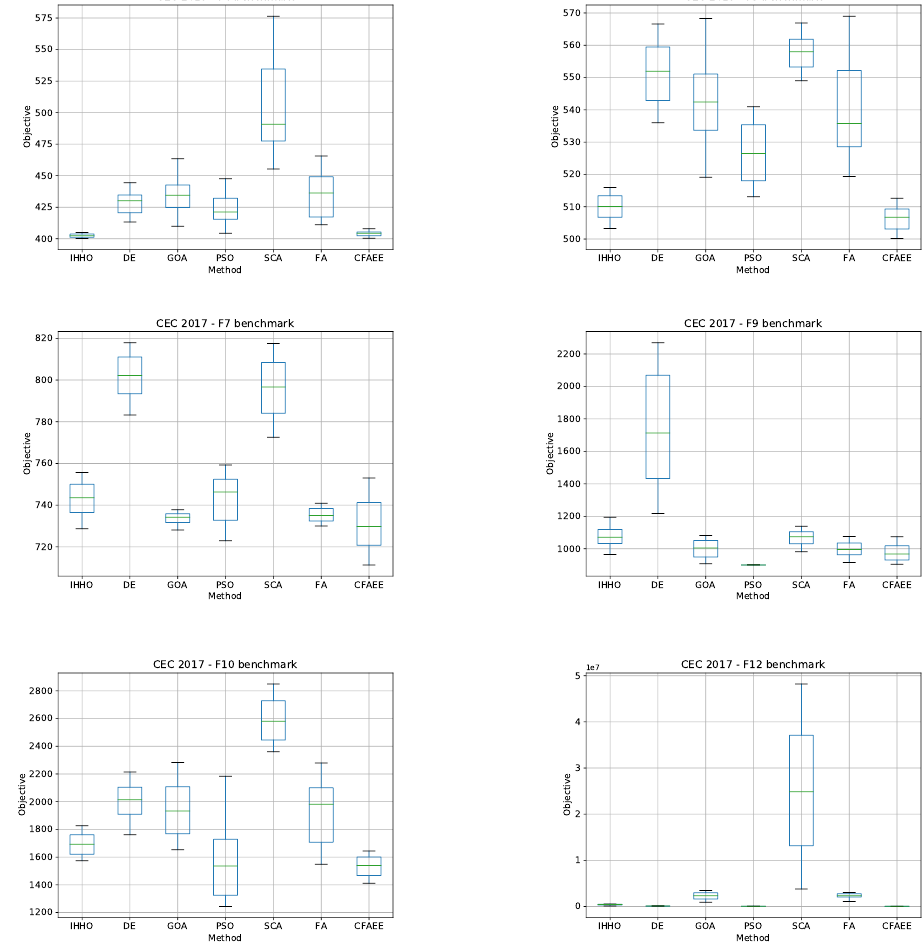
Figure 2. Dispersion of best results over runs for functions F4, F5, F7, F9, F10, F12 (Benchmark set